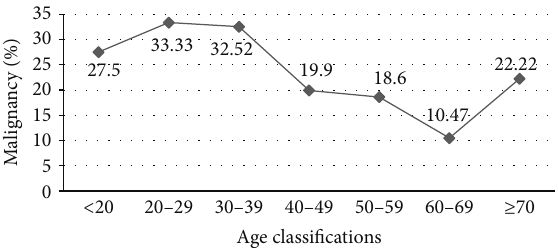
Figure 1: Prevalence of malignancy relative to patient age. Significant increases in the prevalence of malignancy were detected in patients who were younger than 40 years of age ( 𝑝 < 0.001 , compared with the 40–49-year group) and in those older than 70 years ( 𝑝 = 0.036 , compared with the 60–69-year group).